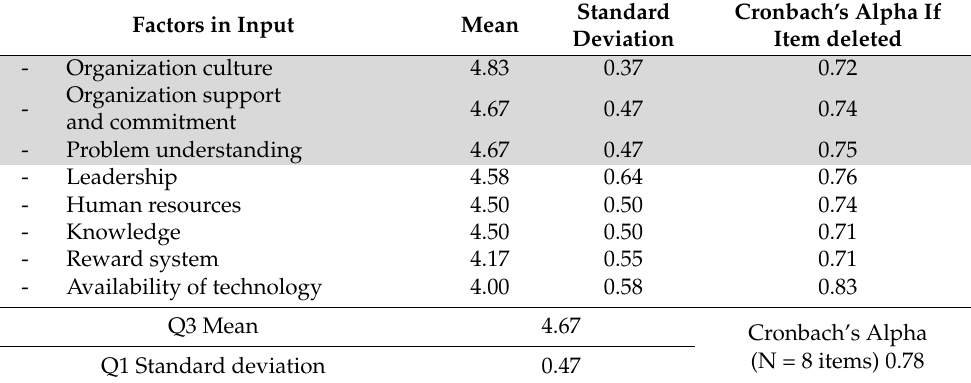
Table 3. Calculation of Q3 mean and Q1 standard deviation of input indicator factors.